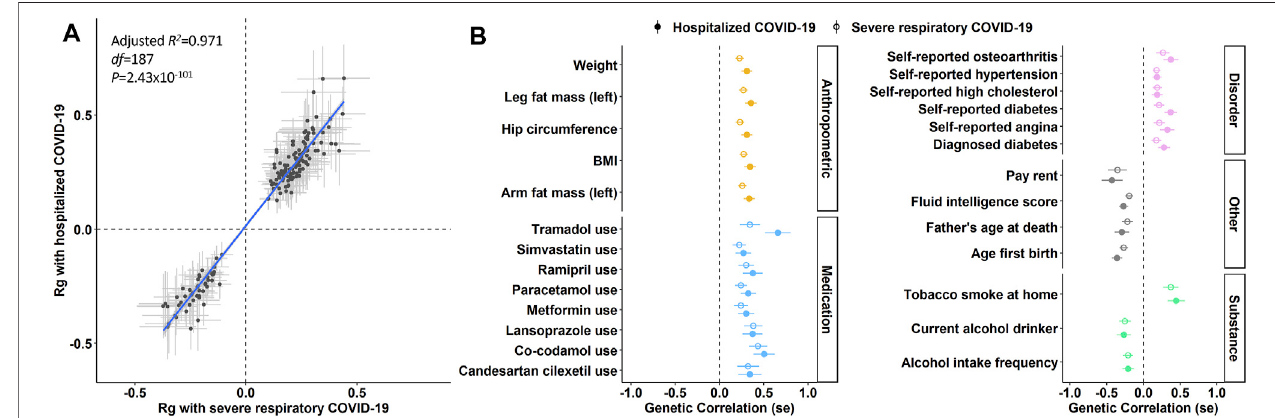
FIGURE1| Pleiotropy ofgenetic riskfor COVID-19 susceptibility. (A) all188 traits with nominally signi fi cantgenetic correlation (Rg) withsevererespiratory COVID- 19andhospitalizedCOVID-19.EachdatapointrepresentsasingletraitanderrorbarsaroundeachdatapointrepresentthestandarderroroftheRgpointestimate.The blue line represents a linear model of Rg magnitude weighted by the standard error of each point estimate. (B) a subset of traits associated with severe respiratory COVID-19(opencircles)andhospitalizedCOVID-19(solidcircles)aftermultipletestingcorrection(total (cid:1) 111traitswithFDRq < 0.05; SupplementaryTableS3 ).